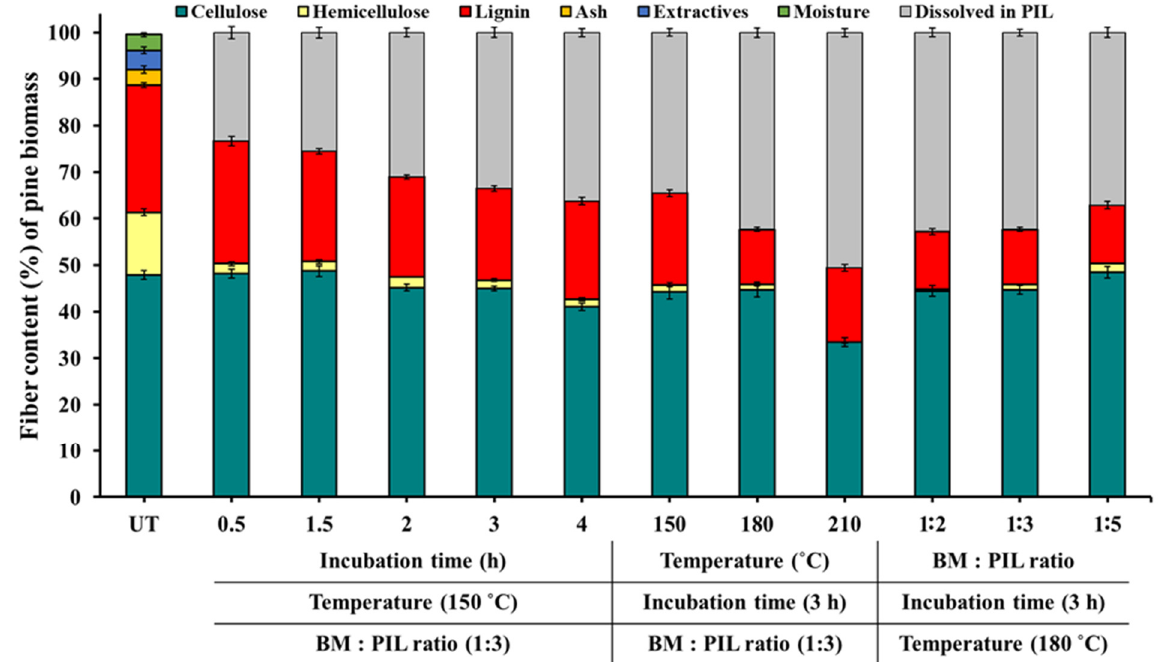
Figure 1. Composition of untreated and [N11H(2OH)][LAC]-treated pine biomass at various pre- treatment conditions.